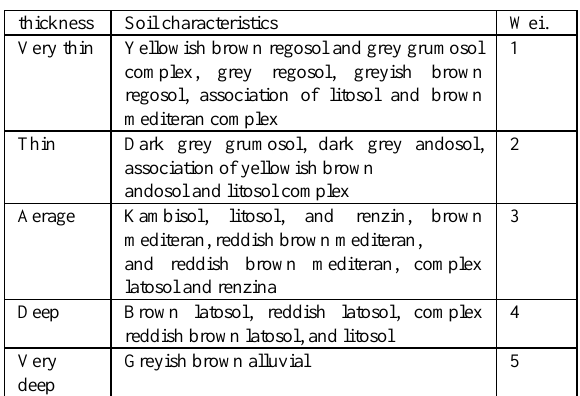
TABLE 6. Classification of Soil characteristics.